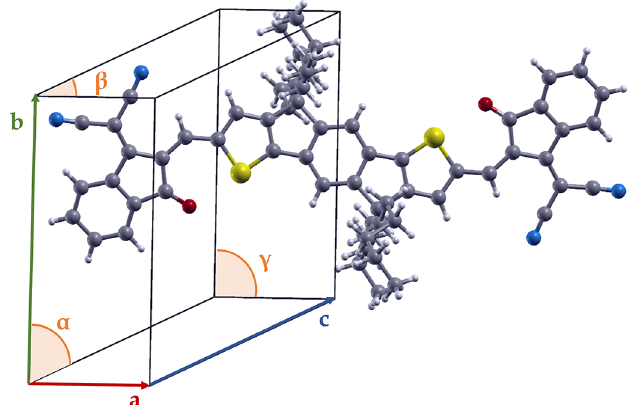
Fig. 6. Unit cell of the parent compound, IDIC-4H. Cell vectors and angles are also displayed.